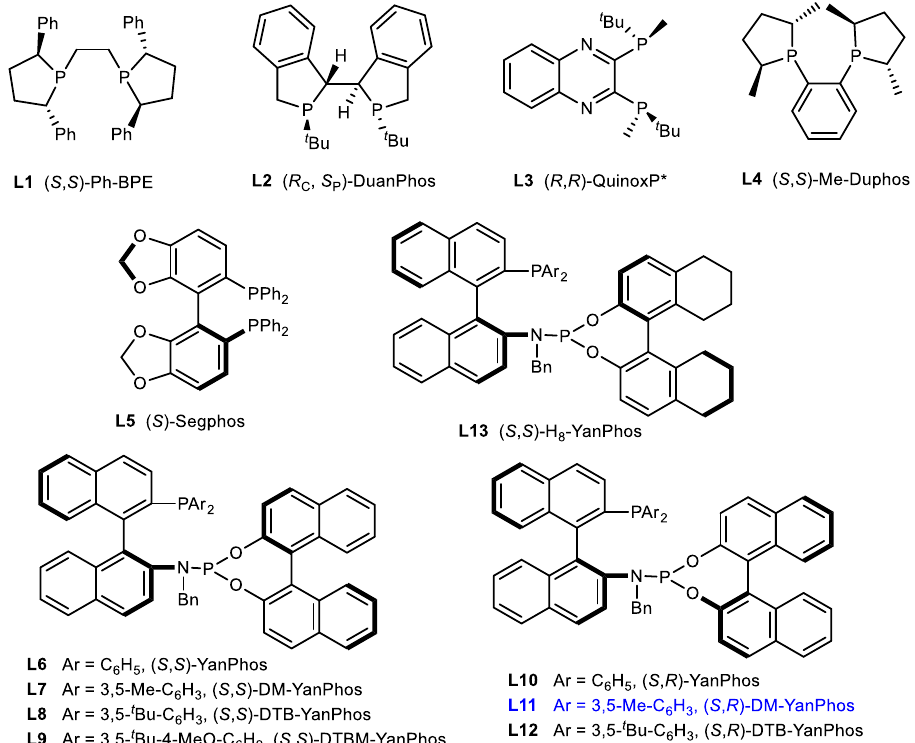
Fig. 3 Ligands evaluation for asymmetric hydroformylation of 1a. L1-L5 are commercially available diphosphine ligands, L6-L13 are Yanphos-type ligands developed in our lab.